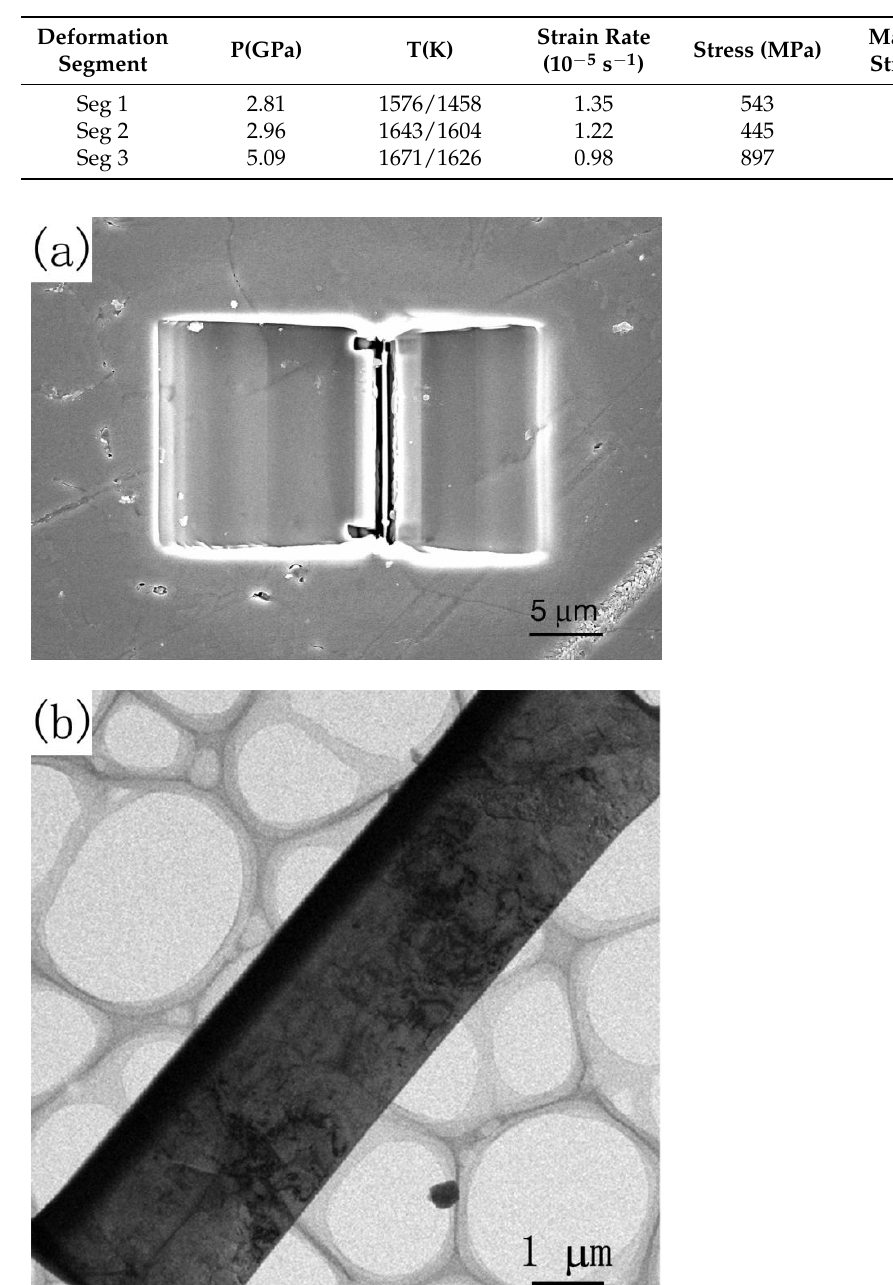
Table 1. Experimental conditions of the studied sample [23].